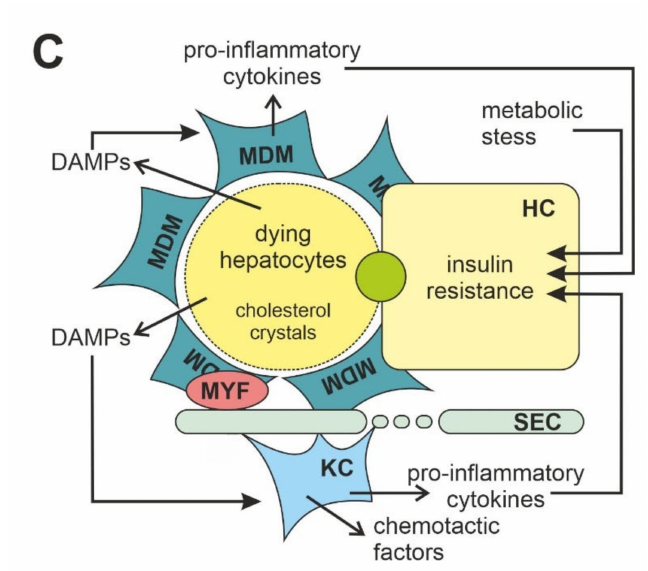
Figure 2. Role of macrophages in the progression of hepatic insulin resistance. ( A ) Normal liver. Functionally normal hepatocytes (HC), hepatic stellate cells (HSC) and sinusoidal endothelial cells (SEC) produce niche factors that maintain Kupffer cells (KC) in a differentiated, non-inflammatory state that allows them to perform their normal physiological function, among others, elimination of gut-derived LPS. Hepatocytes secrete excess cholesterol into the bile. ( B ) Transition state. This hypothetical intermediate state illustrates how an initial impairment of Kupffer cell function can trigger the ensuing low-grade inflammation. Increasing metabolic stress and hyperinsulinemia caused by peripheral insulin resistance increasingly impair HC functions. Reduced production of niche factors and hyperinsulinemia combined with enhanced exposure to activating cues such as danger-associated molecular pattern (DAMP) drive KC towards a more pro-inflammatory state and production of chemotactic factors. ( C ) Inflammation. Attracted by chemotactic factors of KC, monocyte-derived macrophages (MDM) form crown-like structures around dying hepatocytes that release large amounts of DAMPs. Excess cholesterol forms cholesterol crystals. DAMPs and cholesterol crystals activate both MDM and KC to produce pro-inflammatory cytokines that, in concert with metabolic stress, render HC increasingly insulin resistant. HSCs start to transdifferentiate into myofibroblasts (MYF). The non-resolvable inflammation is self-perpetuated by the secretion of chemotactic